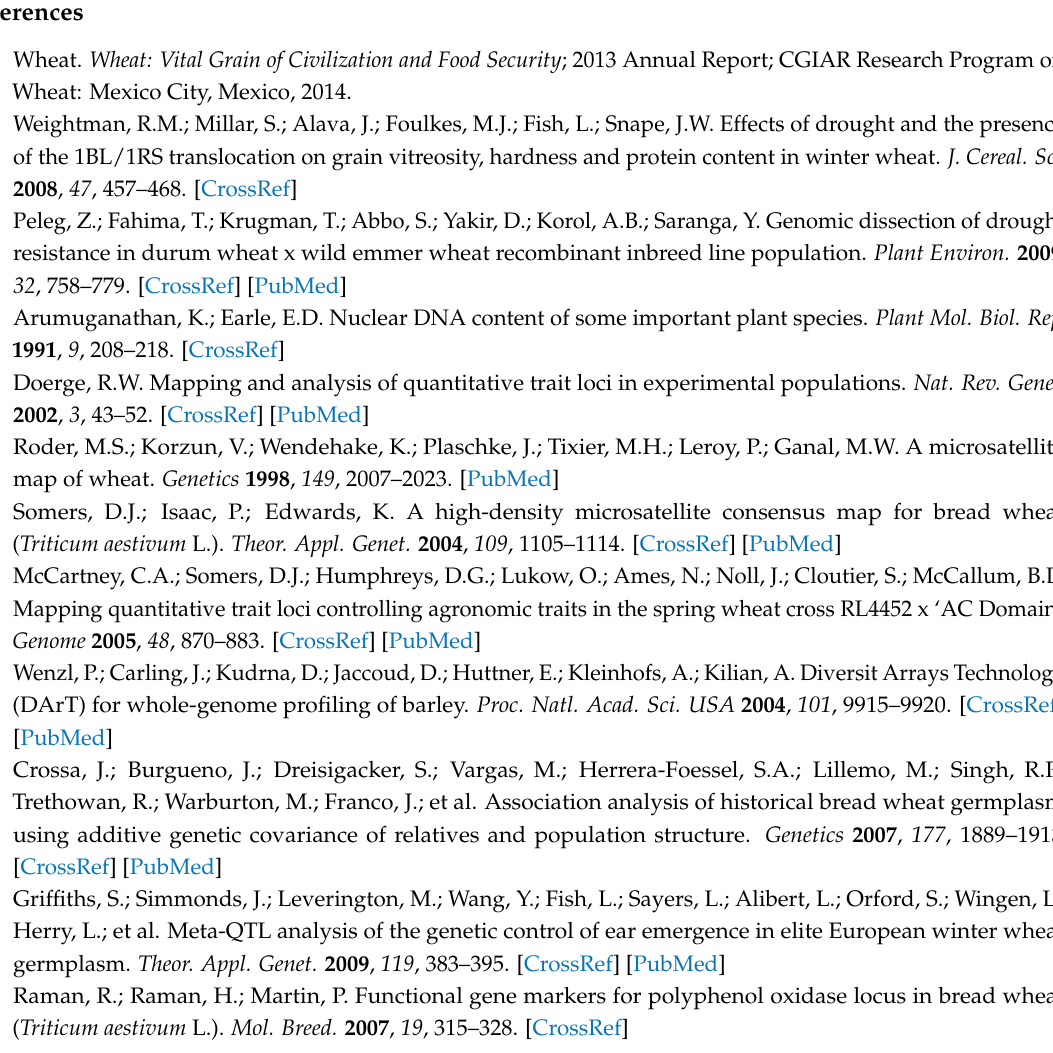
Supplementary Materials: The following are available online at http://www.mdpi.com/2073-4395/8/8/133/ s1, Table S1: Means of agronomic traits for the parents, CO940610 and Platte, under two irrigation levels in the 2007–2008 and 2008–2009 growing seasons. Table S2. Pearson correlation coefficients among agronomic characteristics of the CO940610/Platte population ( n = 185) at Fort Collins under different irrigation levels in the 2007–2008 growing season. Values above the diagonal refer to the fully irrigated treatment and those below the diagonal refer to the limited irrigation treatment. Table S3. Pearson correlation coefficients among agronomic characteristics of the CO940610/Platte population ( n = 185) at Greeley under different irrigation levels in the 2008–2009 growing season. Values above the diagonal refer to the fully irrigated treatment and those below the diagonal refer to the limited irrigation